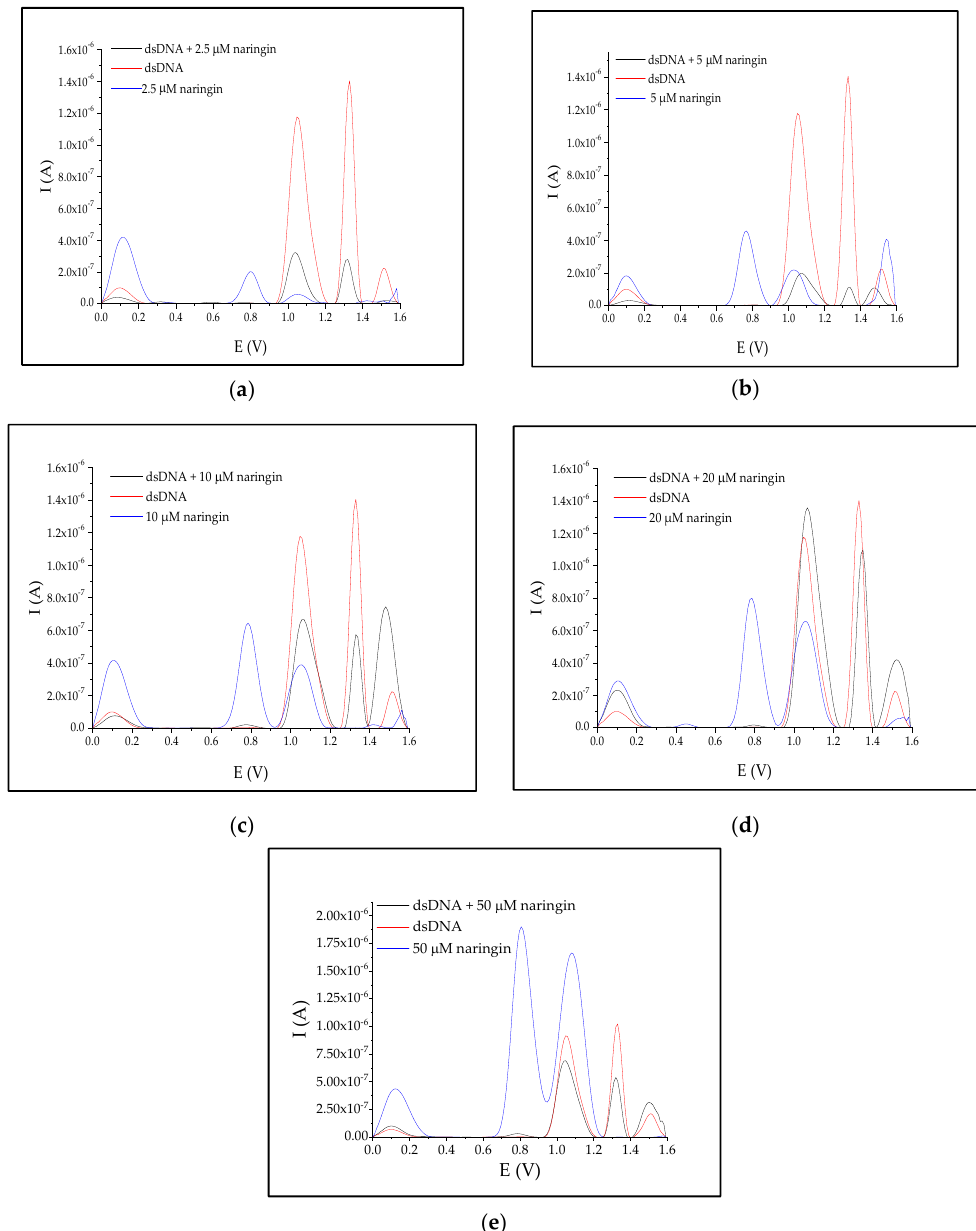
Figure 3. SWV voltamperograms of dsDNA before (red line) and after (black line) interaction with growing concentrations of naringin ( a – e